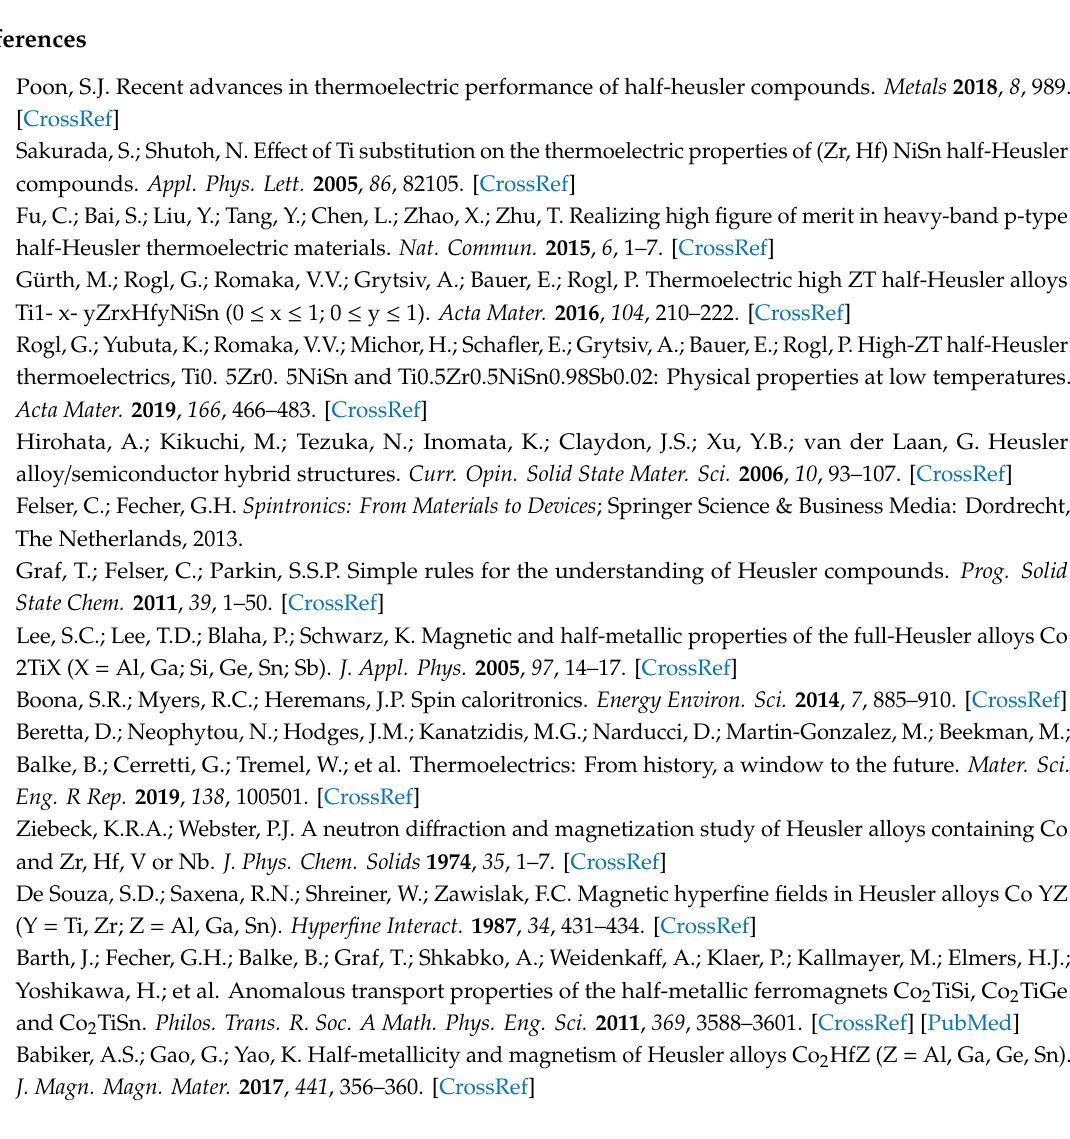
Figure S1: XRD patterns and Rietveld refinements of the Co 2 ZrSn and Co 2 HfSn as-cast and annealed alloys, Figure S2: Backscattered electrons SEM images of the Co 2 ZrSn as-cast and annealed ingots, Figure S3: Backscattered electrons SEM images of the Co 2 HfSn as-cast, and annealed